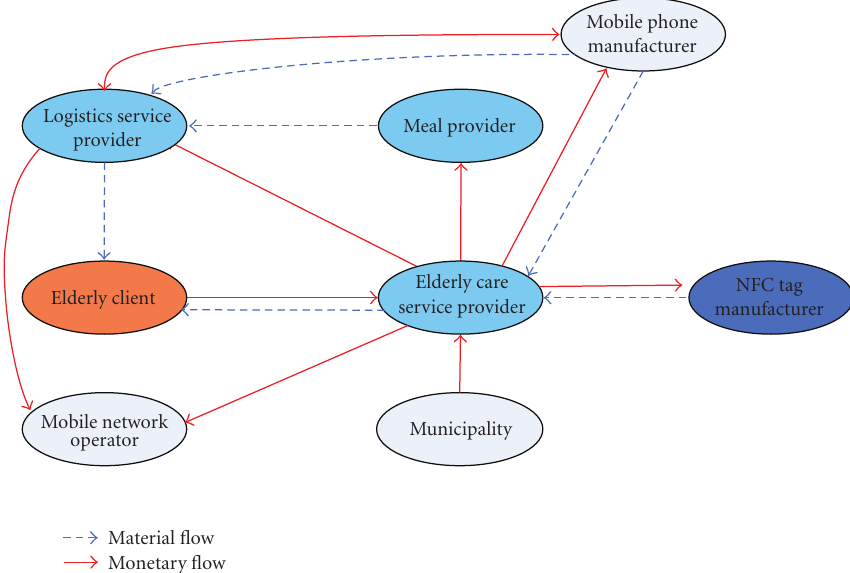
Figure 7: Value net of meal ordering and delivery.